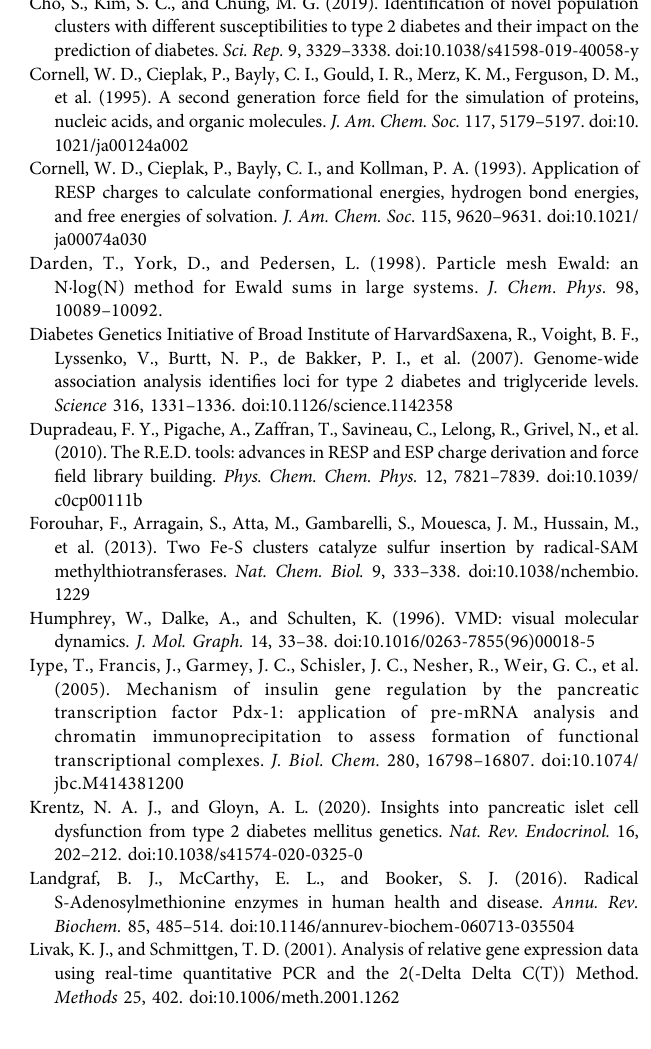
Supplementary Figure S1. Insulin B protein and Cdkal1 protein in NIT-1 knockdown cell lysates . Western blots were employed to identify levels of insulin, Cdkal1 and control GAPDH proteins